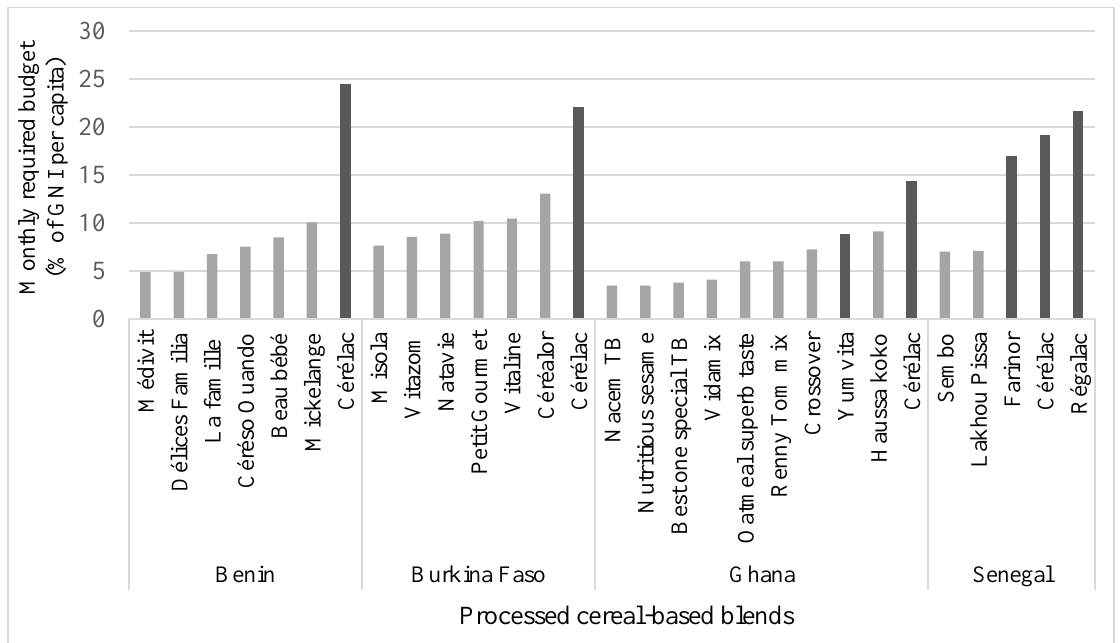
Figure 1. Estimation of the budget required to feed a 6–23 month old child assuming consumption of 50 g of infant flour/day [18] expressed as the percentage of the monthly Gross National Income (GNI) per capita. Darker bars are for products that are imported or produced under license from a large multinational enterprise. (TB, Tom Brown).